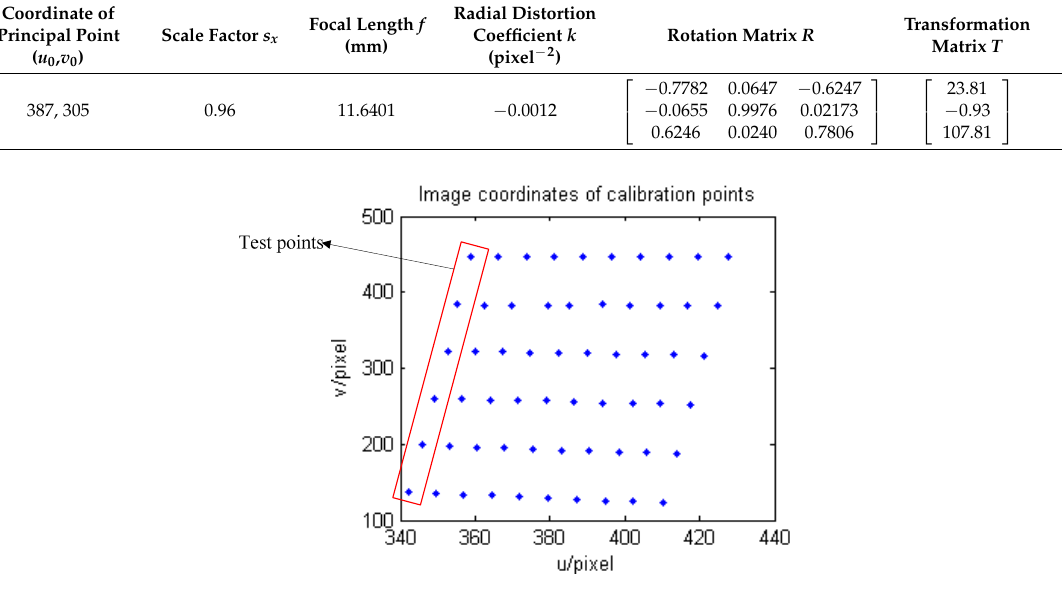
Figure 12. Calculated image coordinates (test points are framed in the red rectangle).